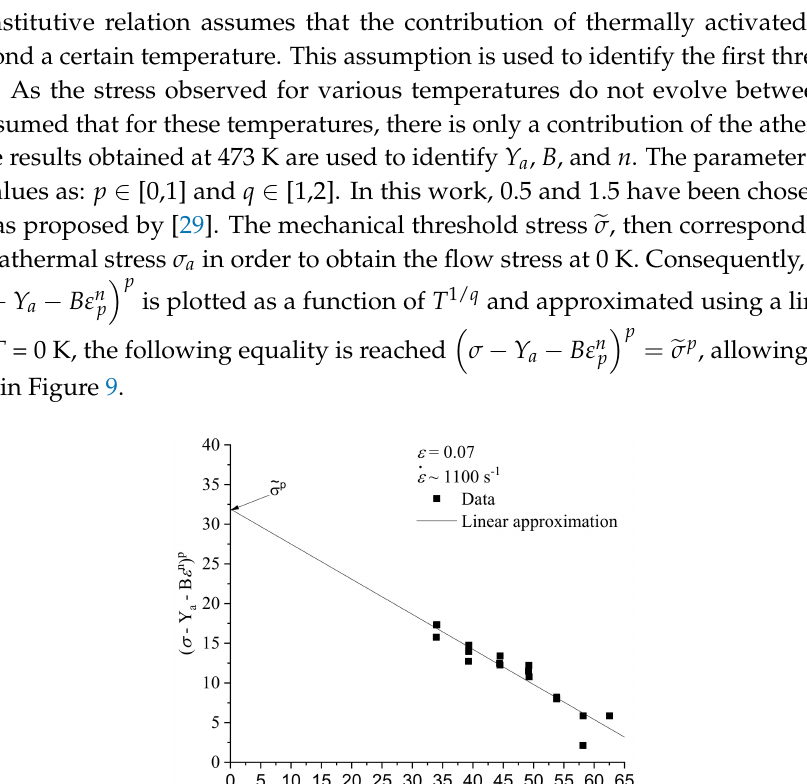
Figure 9. Linear approximation to find (cid:101) σ p